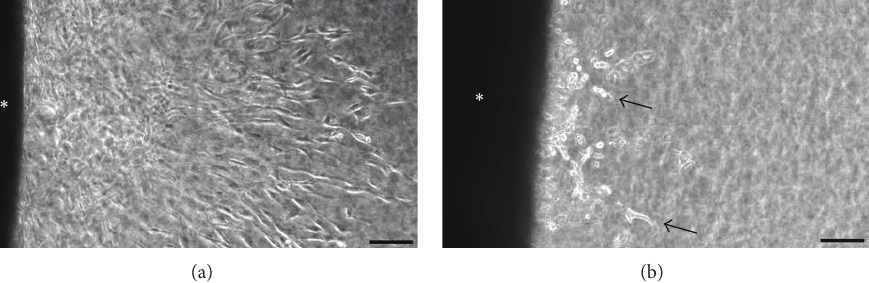
Figure 8: Effect of lovastatin (mevinolin) before tube formation. (a)-(b) When rat aortic rings were cultured with lovastatin, cell migration (arrows) was strongly inhibited relative to the control. (a) = control, (b) = lovastatin, aortic explant ( ∗ ). Scale bar = 100 𝜇 m.